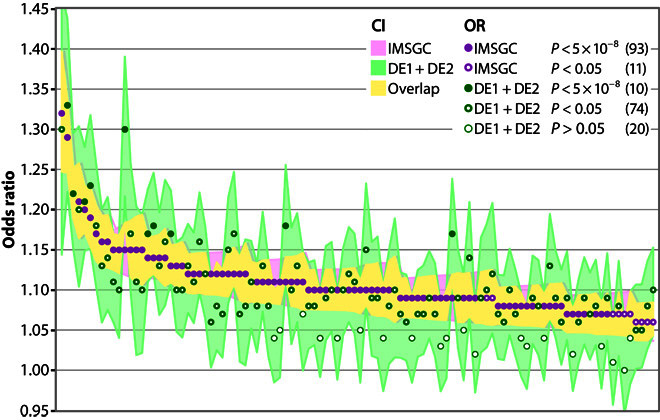
Comparison of results from the pooled analysis of Germans to associations found in an IMSGC study.One hundred and four of the 108 variants showing genome-wide significant or suggestive associations with MS in the study published by the IMSGC in 2013 (4) were present in the pooled results of DE1 and DE2. All 104 variants showed the same direction of effect (P = 5 × 10−32, binomial sign test). Fifty-eight variants had lower ORs and 35 higher ORs compared to the published data set. P value–based categories labeled with different dots represent exclusive bins that add up to 104.